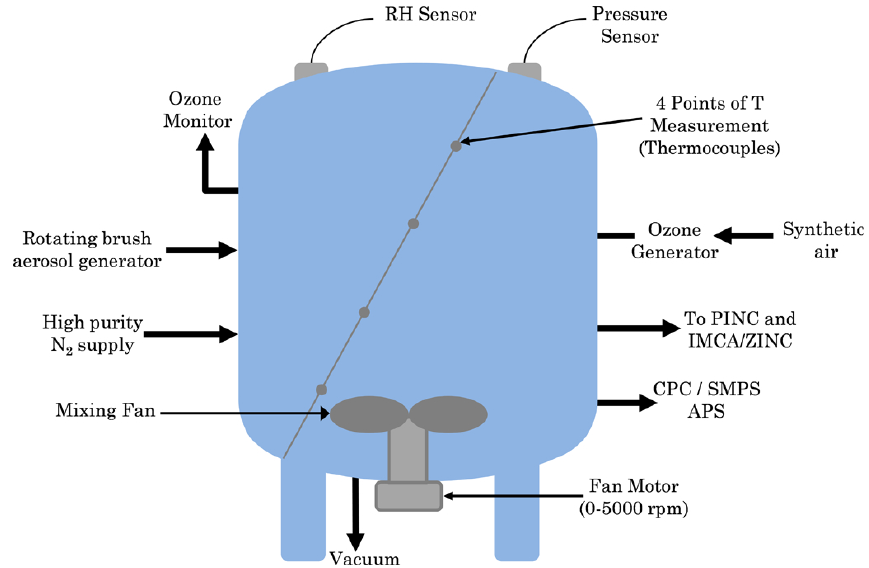
Fig. 1. Schematic of the experimental set-up around the stainless steel aerosol tank. The dimensions given in the text for the tank are taken at the centre of the tank, these are not uniform since the tank has curved